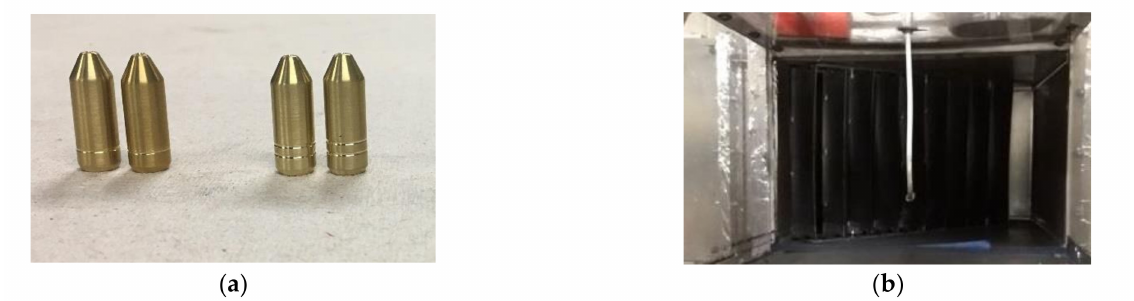
Figure 3. ( a ) Iso-kinetic sampling nozzles; ( b ) sampling nozzles installed